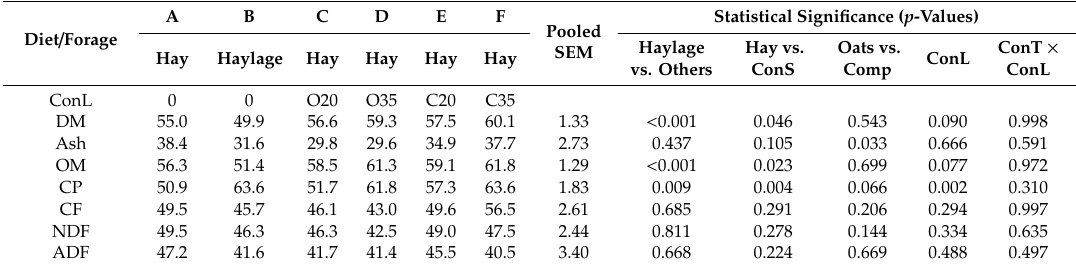
Table 5. Apparent digestibility coe ffi cients (%) of the diet